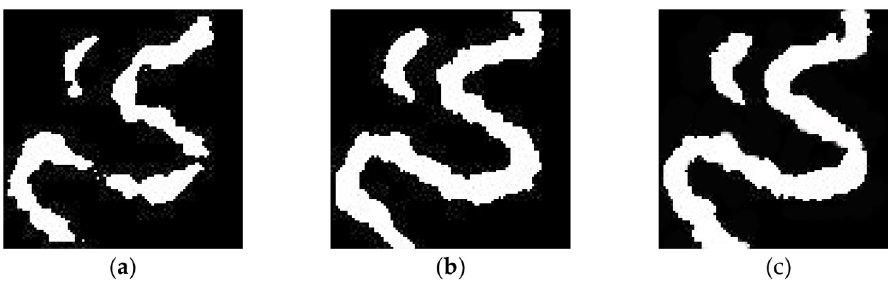
Fig 8. Comparison of the results obtained with different quantities of conditioning data: (a) 100; (b) 200; (c) 300.